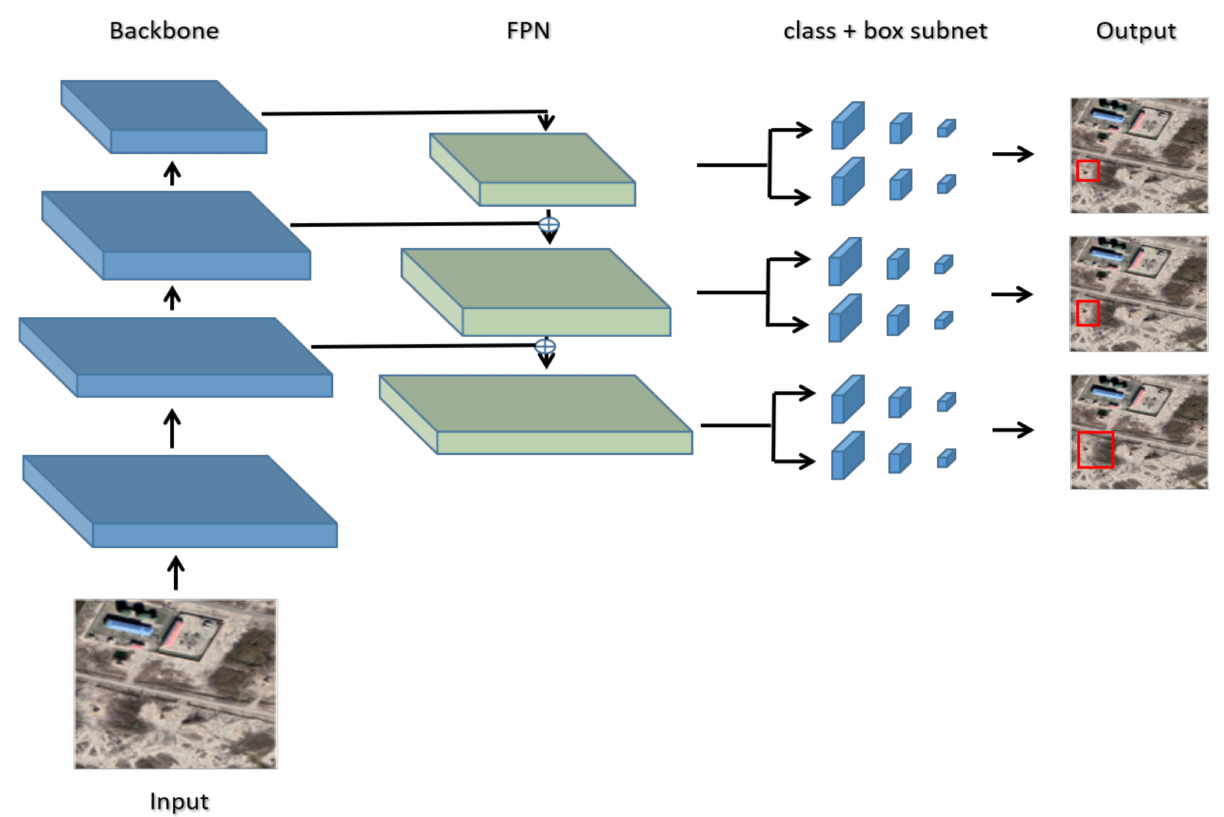
Figure 11. RetinaNet